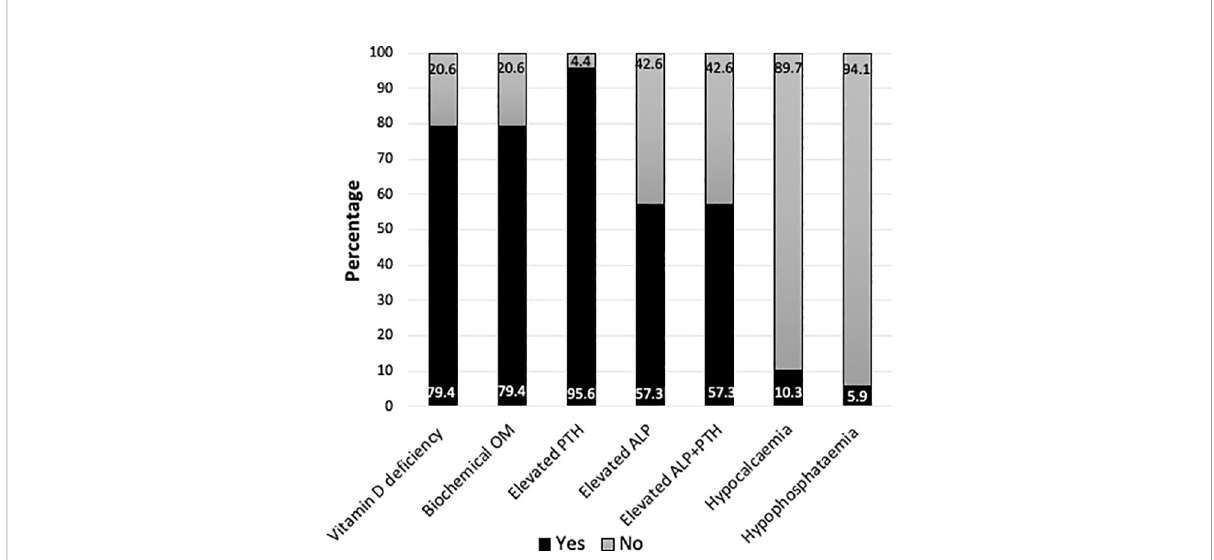
FIGURE 3 Bar chart representing the proportion of siblings with vitamin D de fi ciency (25hydroxyvitamin D <30 nmol/L) (n=54/68), biochemical osteomalacia (OM)* (n=54/68), elevated parathormone (PTH)(n=65/68) or alkaline phosphatase (ALP)(n=39/68) or both (n=39/68), hypocalcaemia (n=7/68) and hypophosphataemia (n=4/68). *Biochemical OM was de fi ned as 25OHD <30 nmol/L + elevated ALP and/or